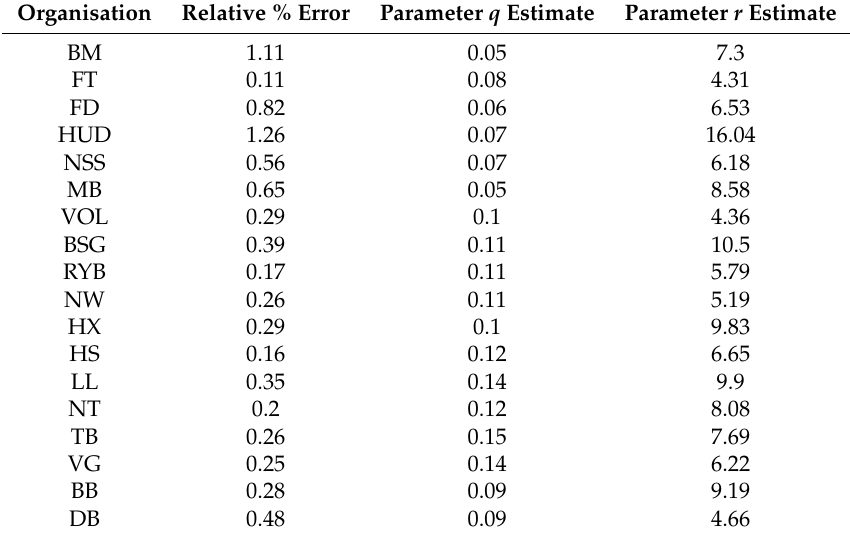
Table A2. Kalman Calculation Parameter